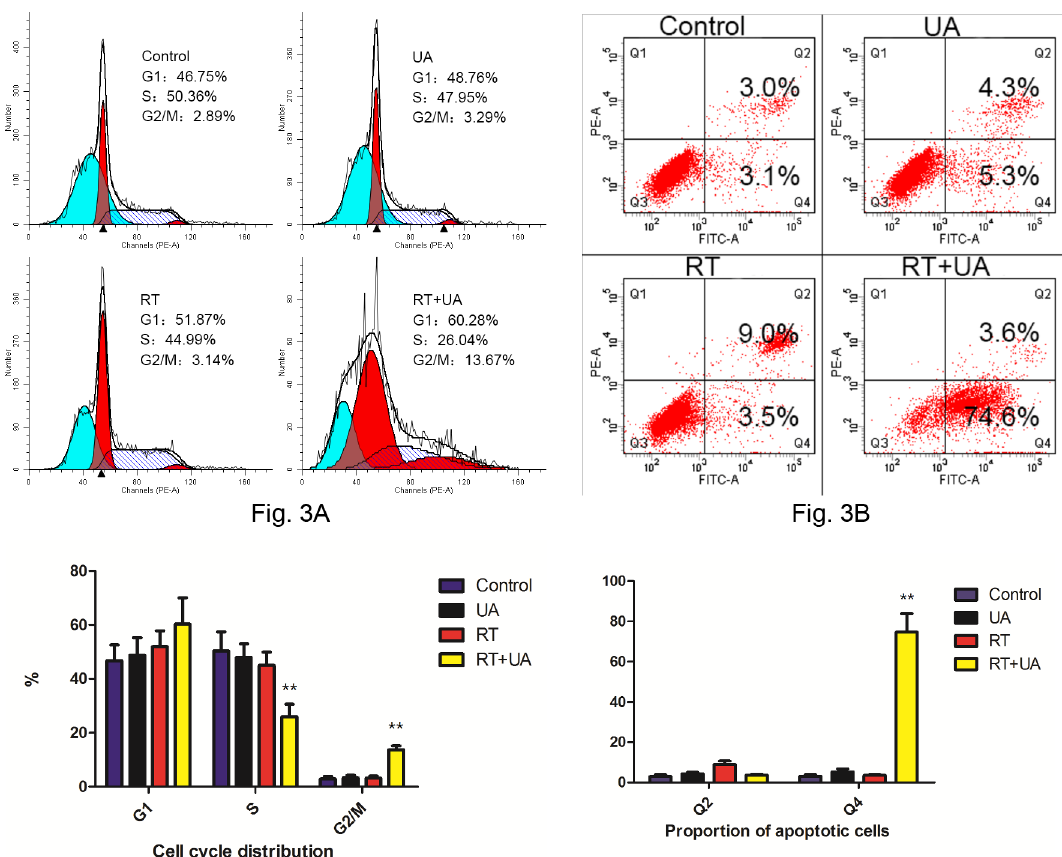
Fig 3. Effects of UA and radiation on cell-cycle progressing and apoptotic cell death of BGC-823 cells. DNA content of fixed and PI-stained cells was measured by flow cytometry, and cell-cycle was analyzed. Percentages of cells in each phase of the cell cycle were provided in each diagram (Fig 3A). Compared with IR group, the addition of UA induced cell cycle arrest at the G 1 phase and G 2 /M phase and a significantly decline of S phase, demonstrating resistance to radiation therapy. Fig 3B showed the proportion of apoptotic cells (annexin V + , PI +/- ). The combination group induced more apoptosis of BGC- 823 cells compared with the other three